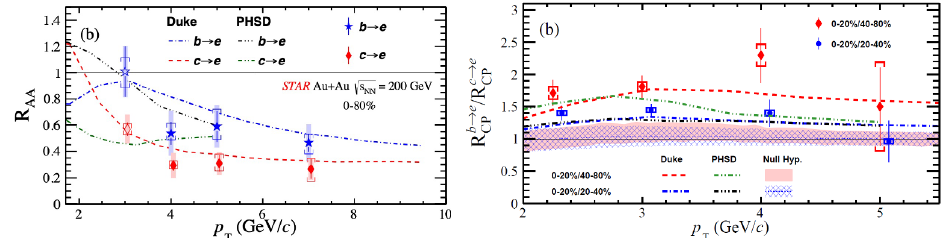
Figure 2: Left: Nuclear modification factor of c → e and b → e decays measured vs. p T by STAR in A + A collisions at 200 GeV [19]. Right: Ratio of R CP of bottom to charm semileptonic decays vs. p T . [19]